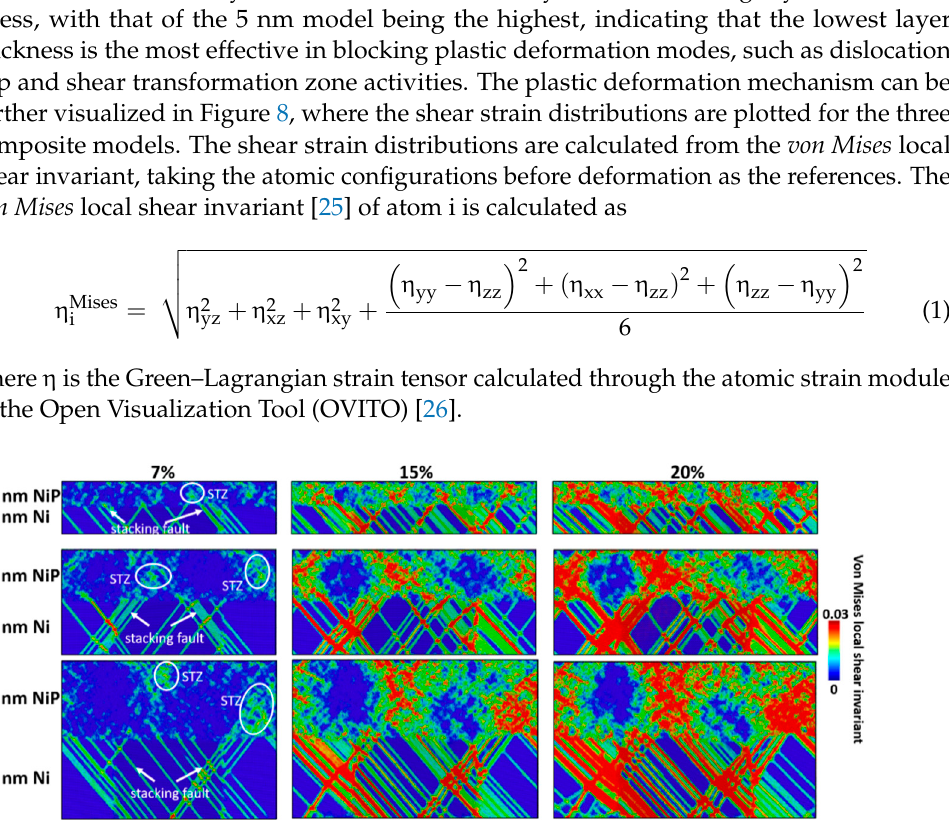
Figure 8. The shear strain distributions at 7%, 15%, and 20% strain during tensile loading of the 5, 10, and 15 nm NiP/Ni composites.